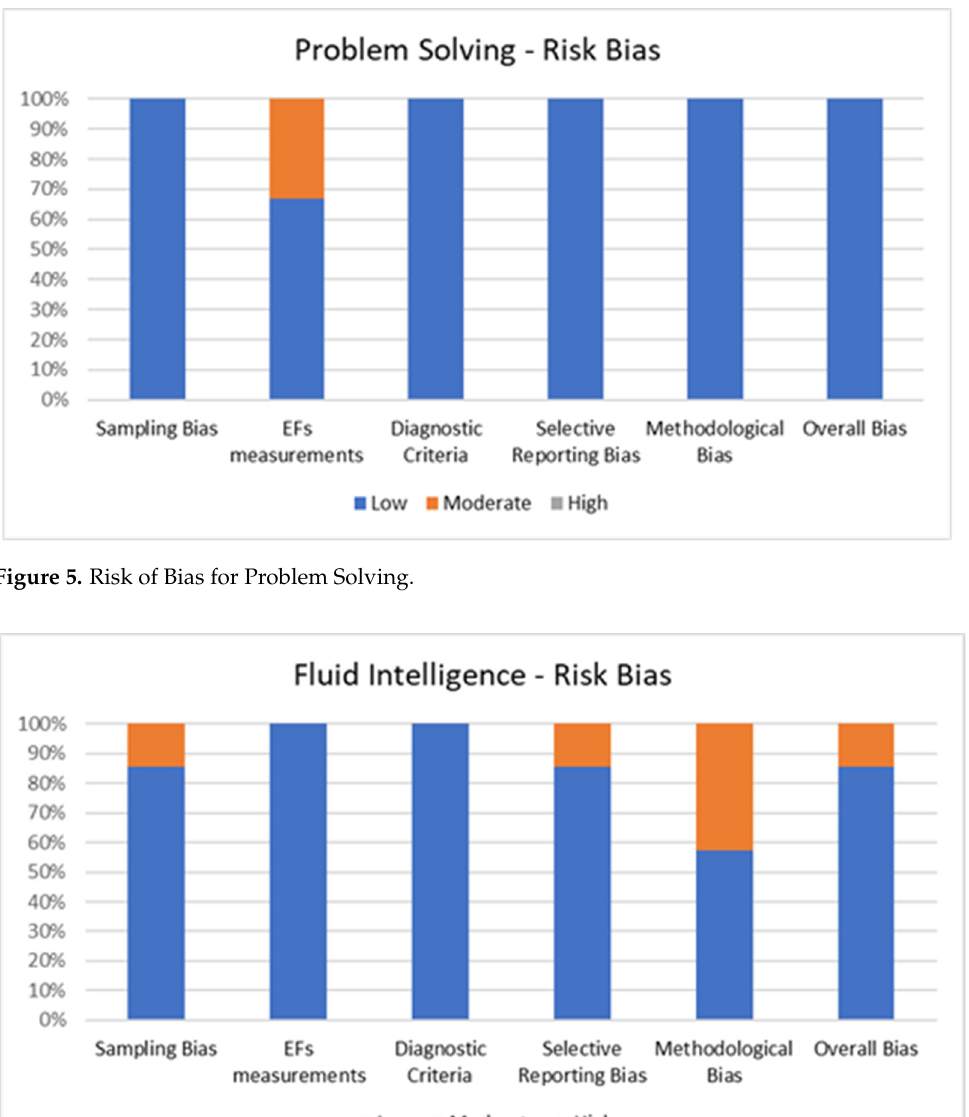
Figure 5. Risk of Bias for Problem Solving.